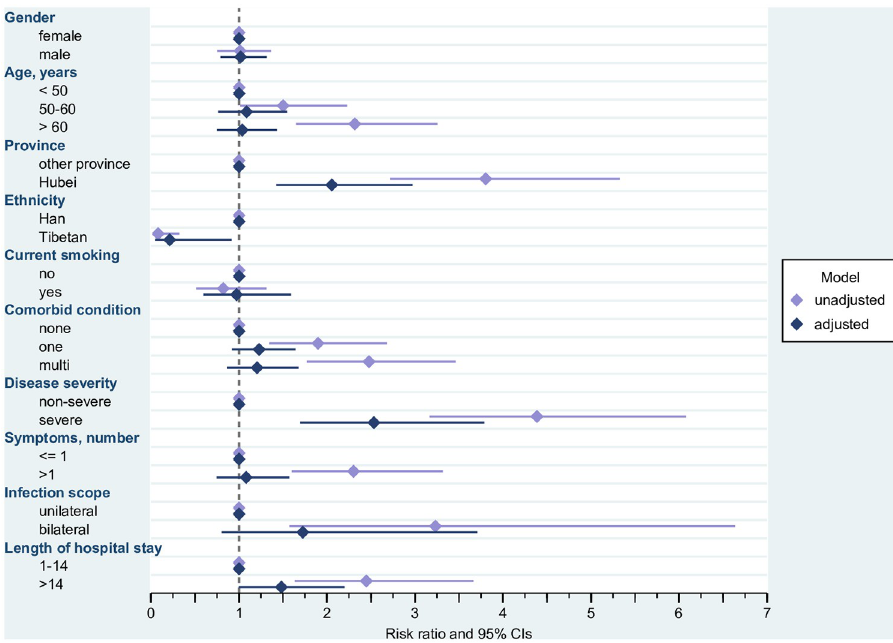
Fig 2. Probable clinical anxiety in relation to potential risk factors. Risk Ratios and 95% confidence intervals. Estimated from log-linear Poisson Regression with robust standard errors; unadjusted risk ratios are estimated from univariable models for the effect of the respective predictor on the outcome, adjusted risk ratios are estimated from a multivariable model containing all potential risk factors. The adjusted model has been estimated for 407 cases (because of missing information regarding length of stay for 24 cases and one case with missing date of birth). & Unadjusted model estimated for 407 cases (because of missing information regarding length of stay for 24 cases and one case with missing date of birth). CI = confidence